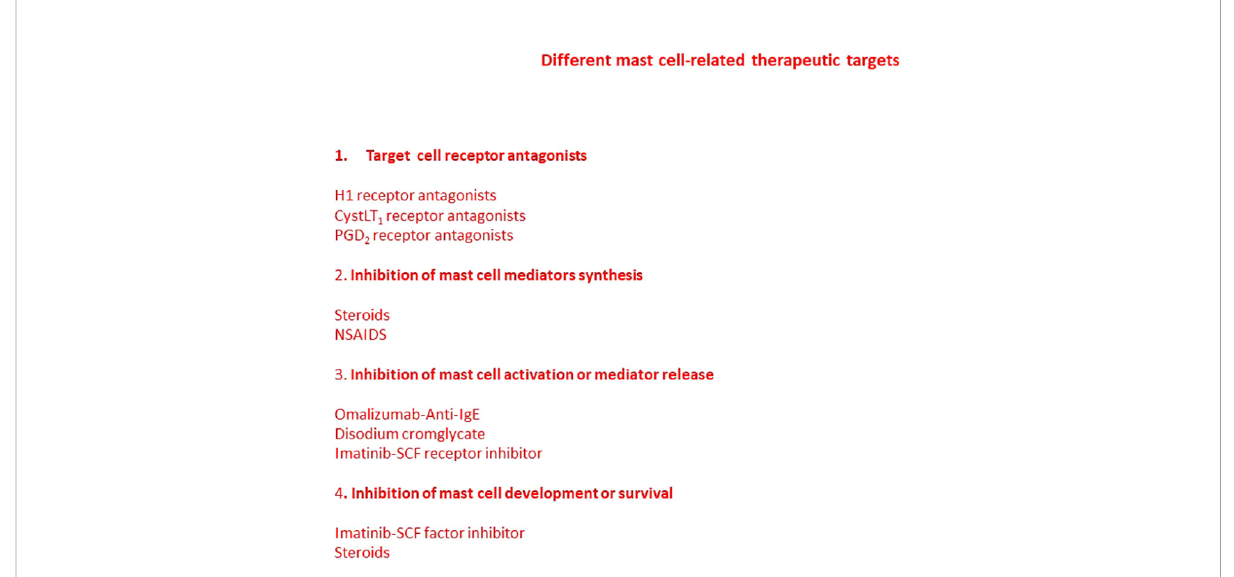
FIGURE 4 Mast cell-related therapeutic targets. Many pharmacological agents have been developed able to modulate mast cells functions. Some drugs block mediator receptors on target cells, inhibit mast cell mediator synthesis, block mast cell activation or mediator release, or inhibit mast cell development and maturation. Some drugs may act through more than one mechanism. However, new strategies and targets are